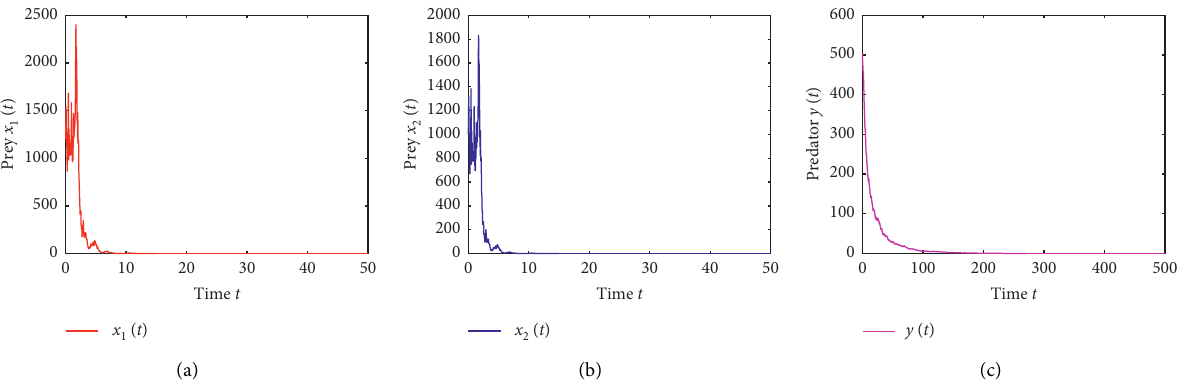
Figure 22: The trajectories of stochastic model (5) with σ 2 and (c) predator y ( t )